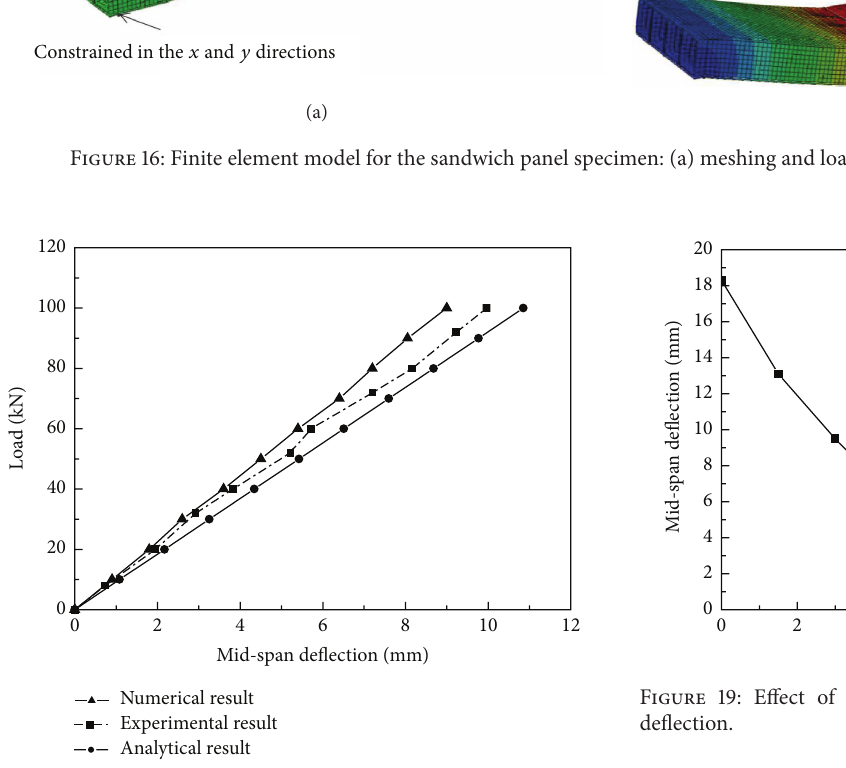
Figure 17: Contrast of the mid-span deflections of specimen S( 6 )- GFRP.